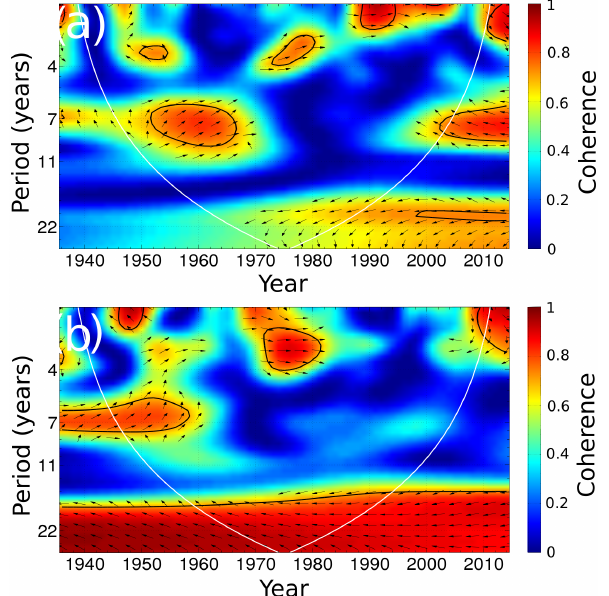
Figure 6. Wavelet coherence spectrum between annual average temperature for (a) TOR and SN22 and (b) for IRA and SN22. The black arrows represent the phase angle between the temperature and the double sunspot cycle. Further legend information is the same as for Fig. 5.